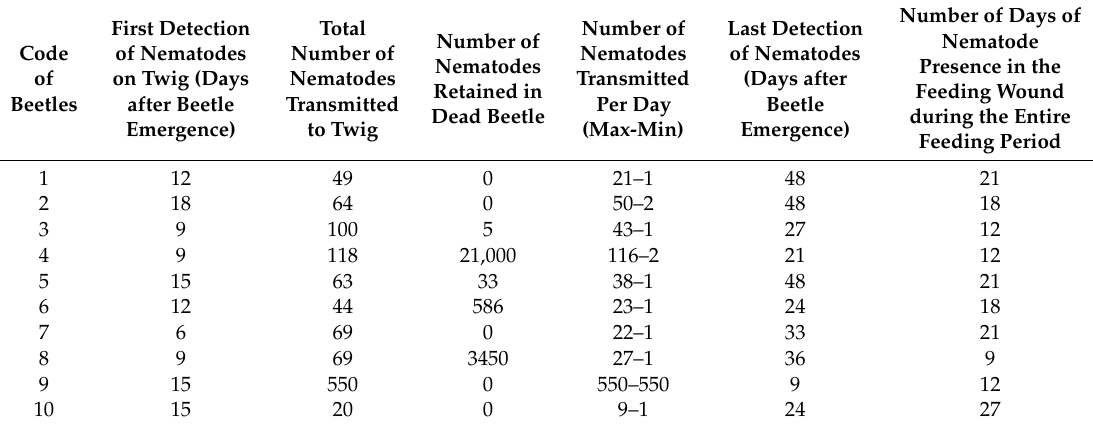
Table 2. Number of Bursaphelenchus xylophilus isolated from treated trees in the experimental cage. Data represent the means ± SD of three replicates.